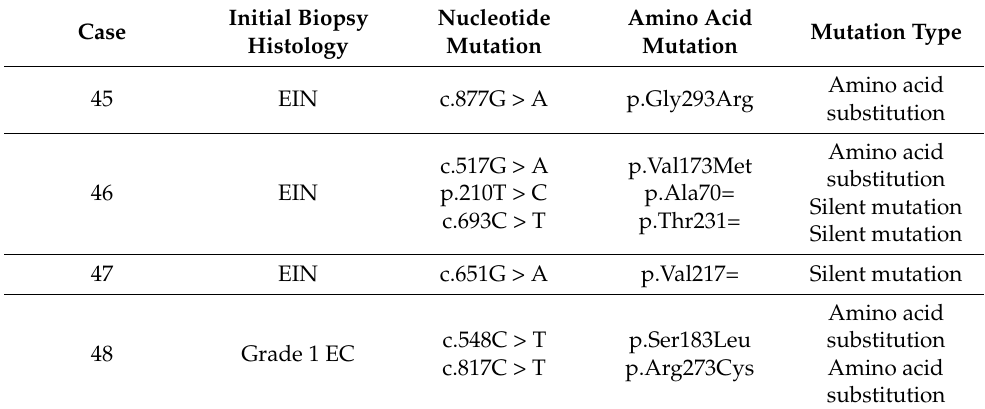
Table 3. Nucleotide and amino acid substitutions in tumors with strong and diffuse expression of p53 by immunohistochemistry.